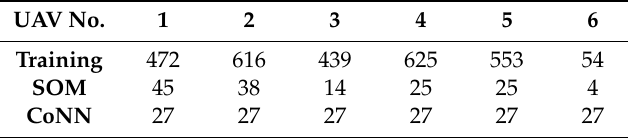
Table 9. Set number of labeled (annotation) prototypes structure has been obtained. UAV No.